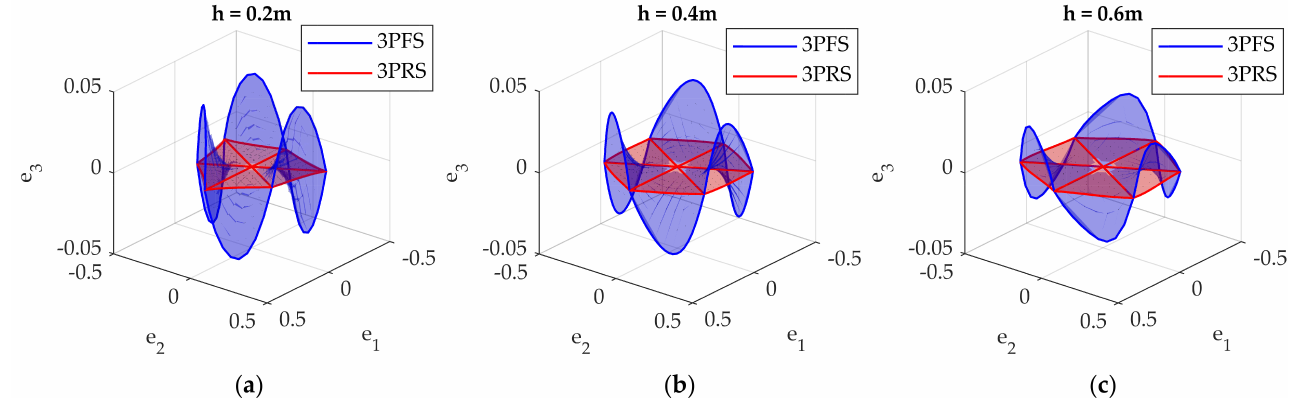
Figure 11. Parasitic motion e 3 comparison.